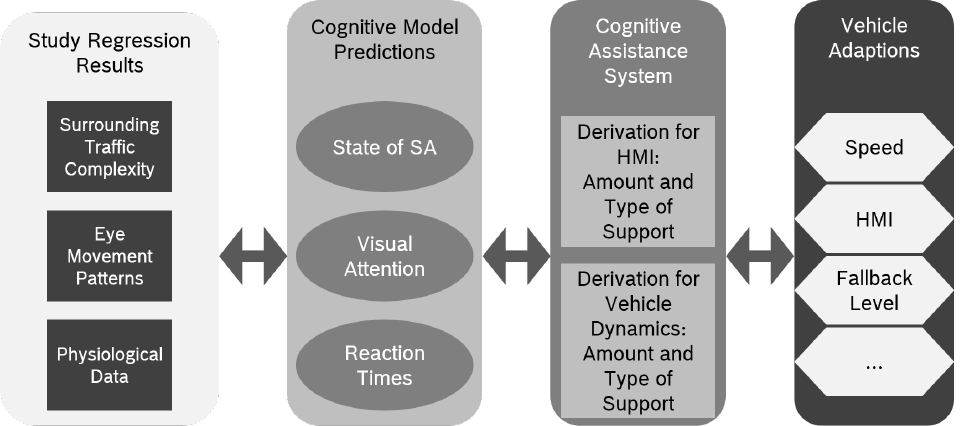
Figure 8. Usage of the cognitive model to support situational adaptions of adaptive assistance systems in highly automated driving (source: own